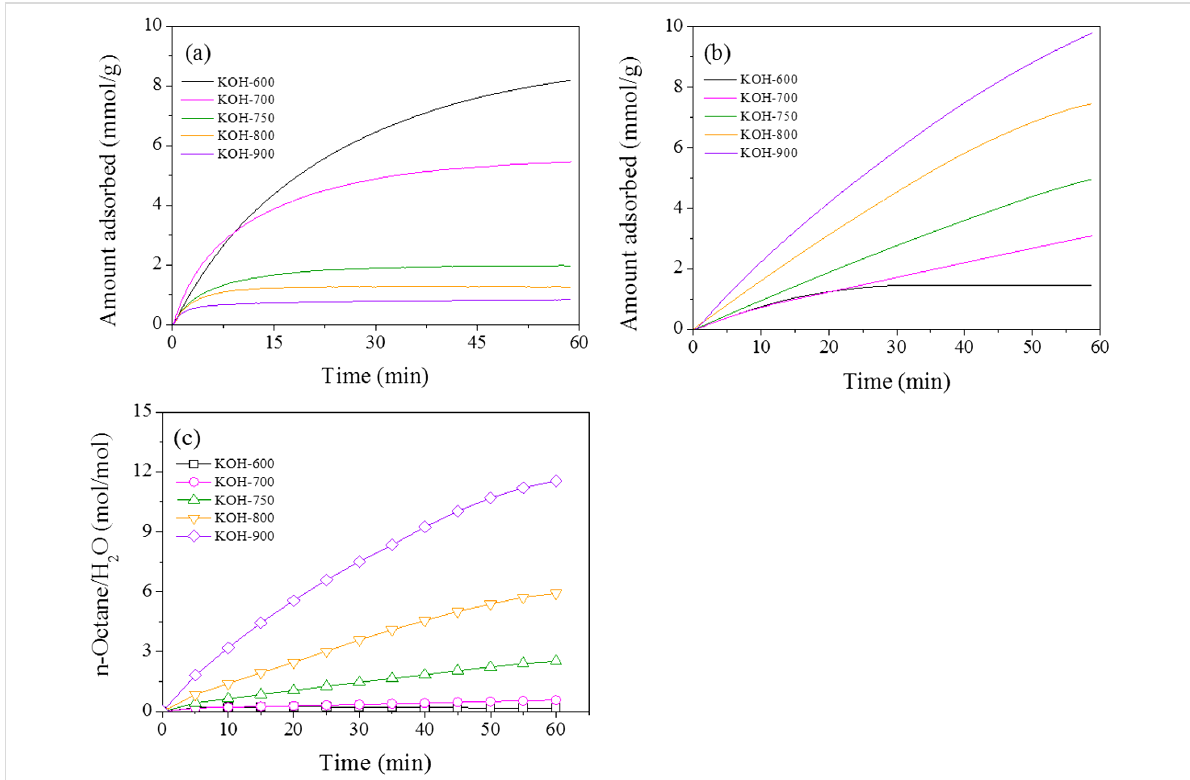
Figure 2: Amount of adsorbed (a) H 2 O and (b) n -octane over PDC materials. (c) Ratios of adsorbed amounts of n -octane/H 2 O over PDC materials.